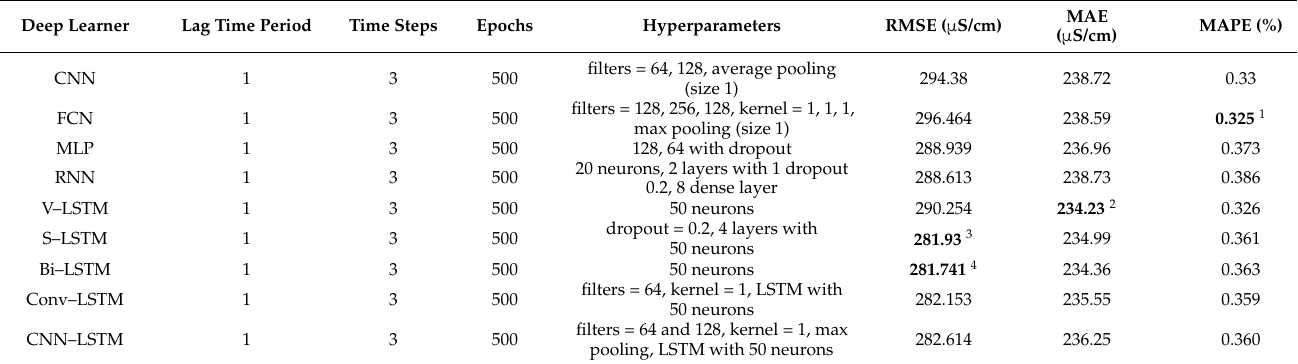
Table 5. Results for the optically active parameter EC for the multi–step (t + 1, t + 2, t + 3) events.